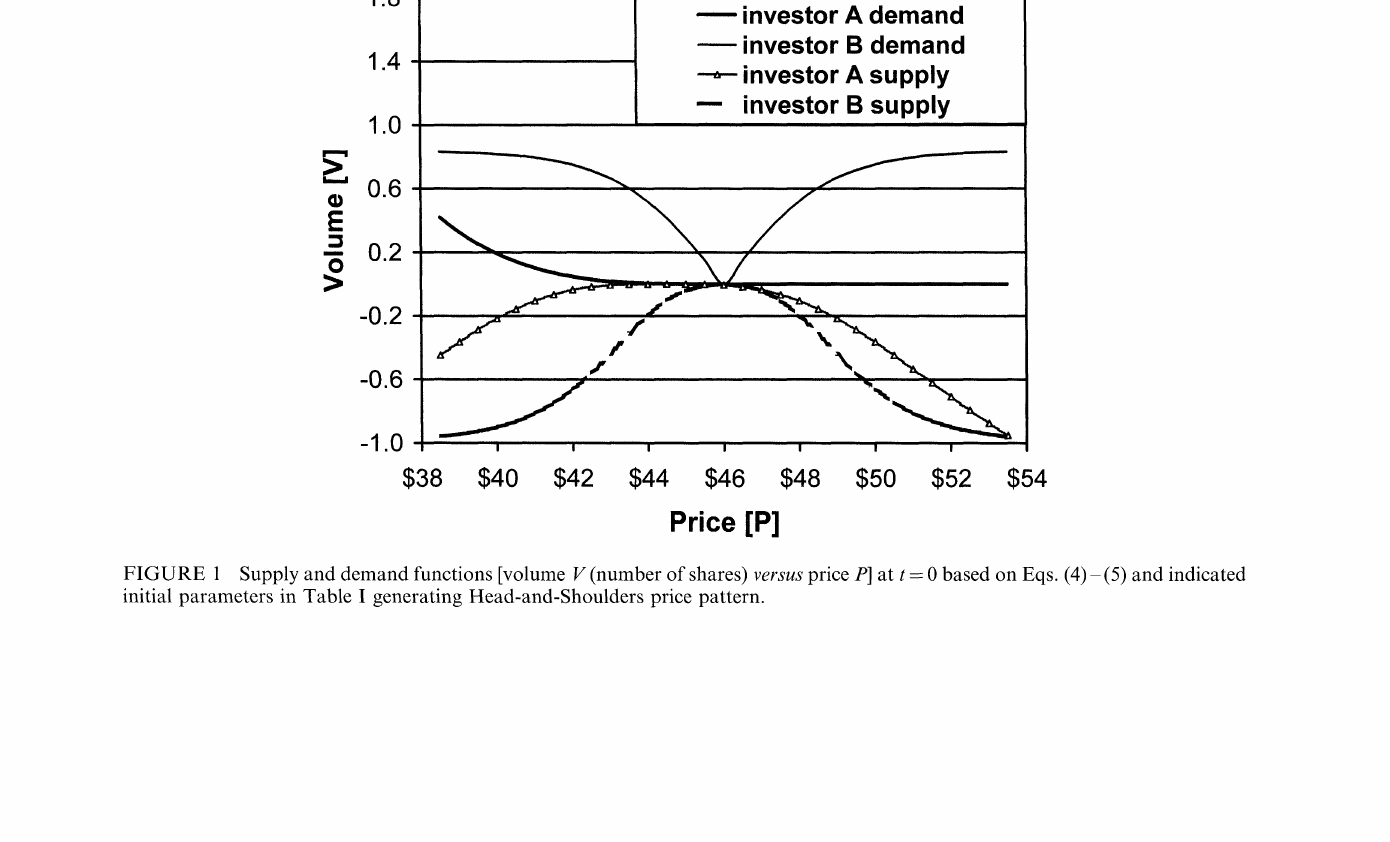
Supply and demand functions [volume V (number of shares) versus price P] at t-- 0 based on Eqs. (4)-(5) and indicated initial parameters in Table generating Head-and-Shoulders price